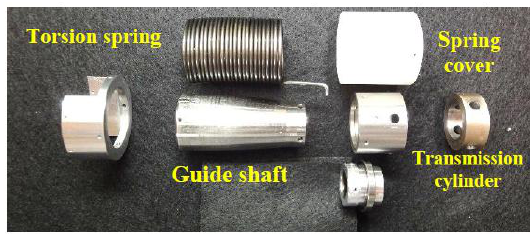
Figure 2. Non-Linear Elasticity Module (NLEM).